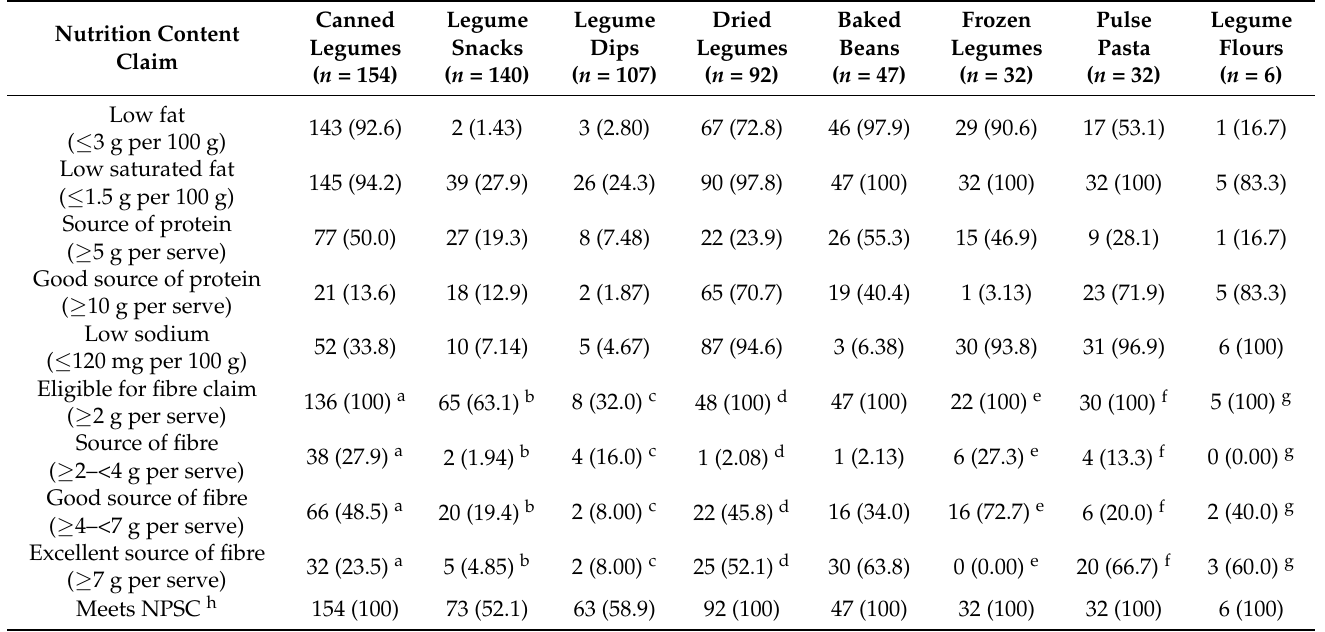
Table 4. The number and proportion of products meeting eligibility criteria for on-pack claims and NPSC in 2021; n (% of category).